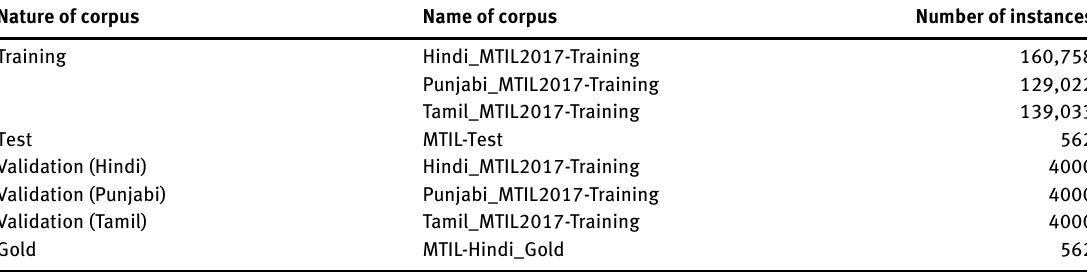
Table 1: Corpora